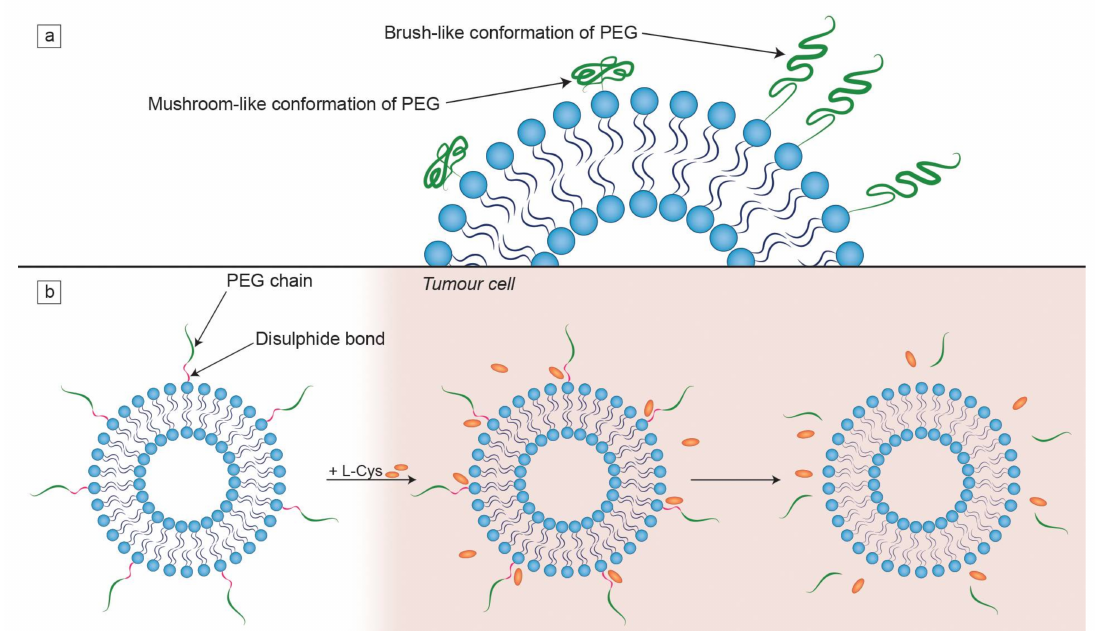
Figure 4. Characteristics of PEG chains on the liposomal surface. ( a ) The dependence of the PEG chain conformation on its surface density. When PEG chains are engrafted at a higher density, the brush-like conformation is favoured; ( b ) the mechanism of detachment of PEG chains from a liposome by the L-cysteine (L-Cys) that is found at an elevated concentration in tumor cells. This illustration was developed based on a procedure described in a study by Kuai et al.